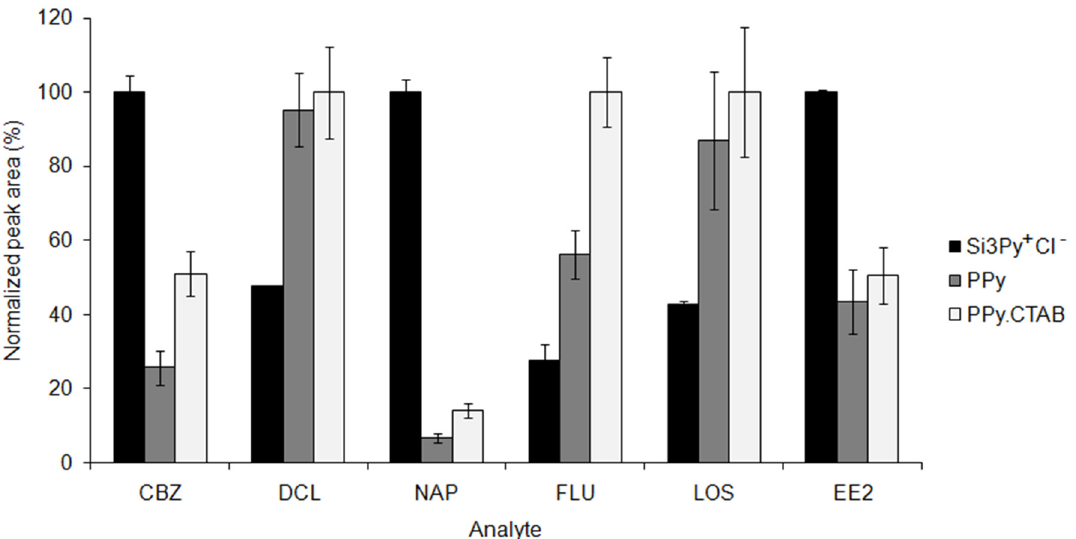
Figure 1. Univariate evaluation of extraction phases Si3Py + Cl − , Ppy, and PPy.CTAB using the DPX procedure in the extraction of CBZ, DCL, NAP, FLU, LOS, and EE2. Extraction was performed with 20 mg of each material; 100 µ g L − 1 of each analyte; five extraction cycles with 800 µ L of sample in each cycle, and 15 s of extraction time; and five desorption cycles with 100 µ L of ACN: MeOH, 1:1 v / v (same aliquot), and 15 s of desorption time.